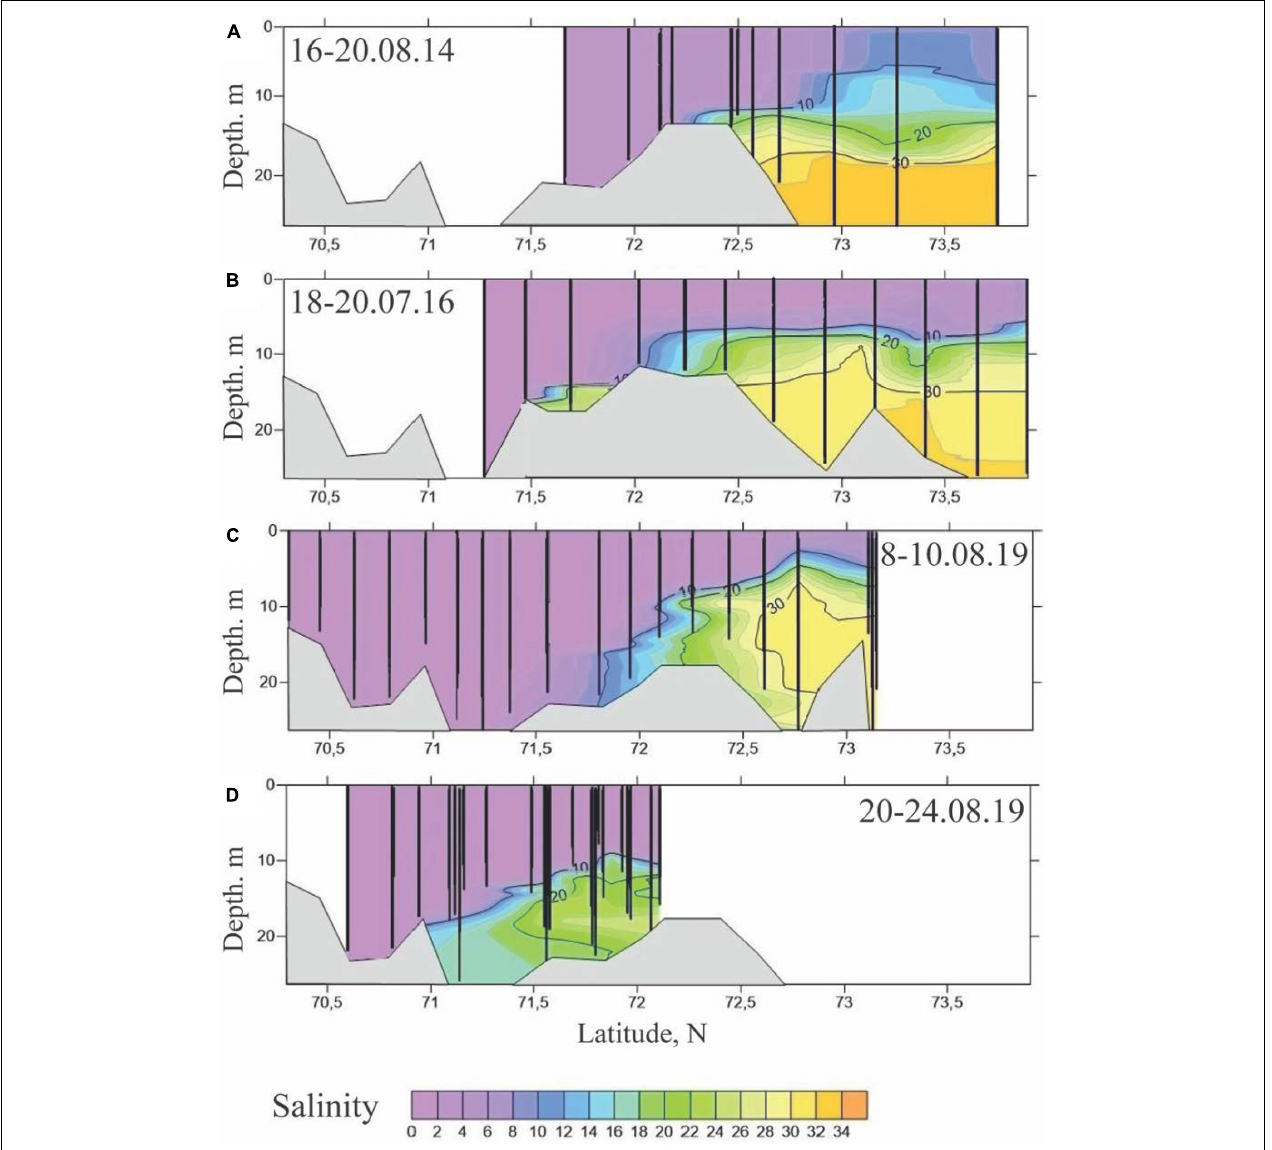
FIGURE 4 | Salinity structure along the transect in the Gulf of Ob on August 16–20, 2014 (A) , July 18–20, 2016 (B) , August 8–10, 2019 (C) , and August 20–24, 2019 (D) . Black vertical lines represent salinity measurements at the hydrographic